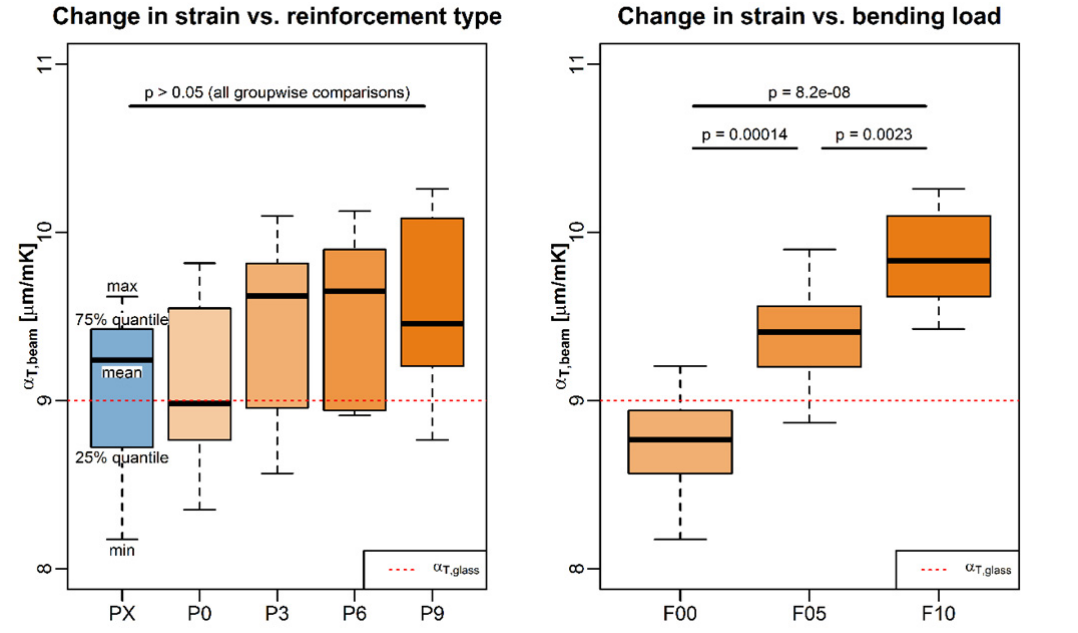
Fig. 11 Change in strain grouped by reinforcement type (left) and bending load (right) including t-test results at 95% confidence